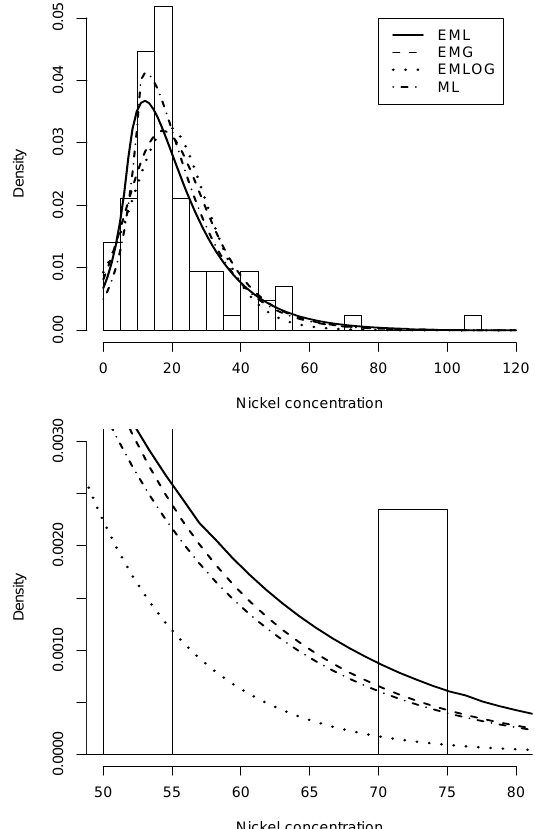
Figure 5. Histogram ( upper ) and tail ( lower ) for nickel concentration data set. Overlaid on top is the density EML with parameters estimated via MLE (solid line), exponentially modified Gaussian density with parameters estimated via MLE (dotted line), exponentially modified logistic (dashed line), and modified Laplace (dash-dotted